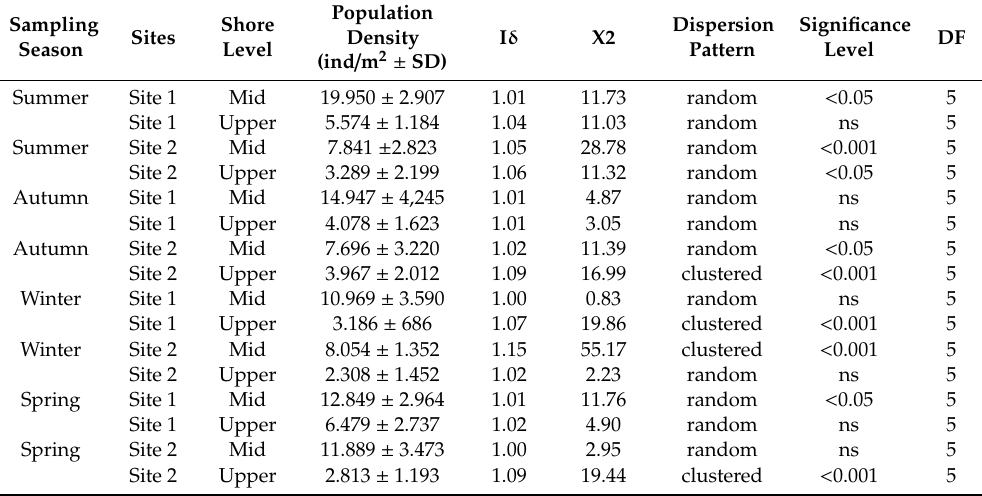
Table 5. Population density (ind m − 2 ) and dispersion pattern of C. stellatus populations per sampling site, level, and period, (standard deviation (SD), Morisita index of aggregation (I δ ), degrees of freedom (DF), chi-square values corresponding to the statistic obtained with an indication of their significance at 95% confidence level (X 2 ), ns (no